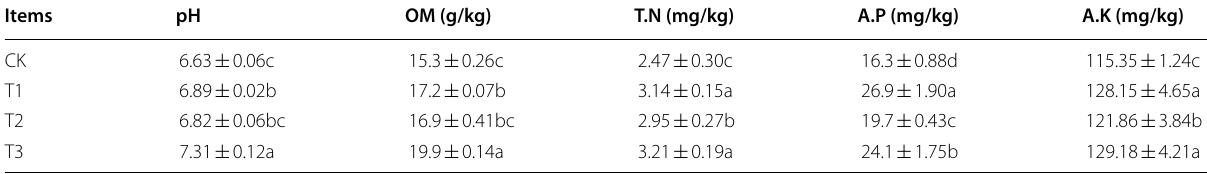
Here OM organic matter, TN total nitrogen, AP available phosphorus, AK available potassium Different letters in the same column meant significant differences among treatments according to Duncan’s multiple range test at P < 0.05